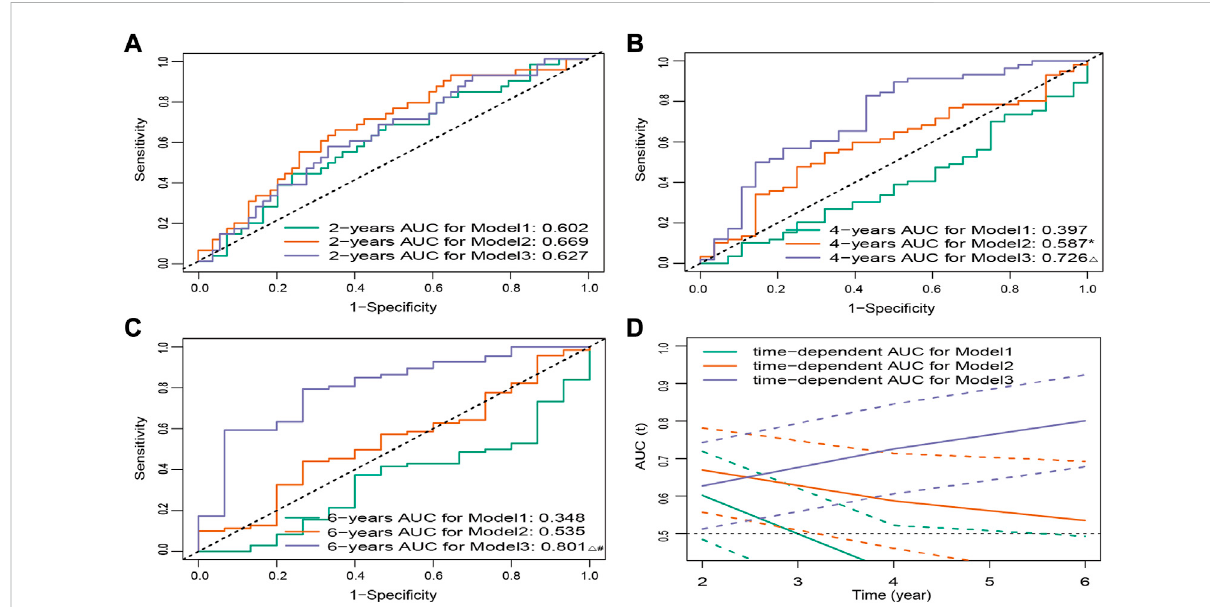
FIGURE 5 ROC curves for three models of predicting 2- (A) , 4- (B) , and 6-year (C) OS. * p < 0.05 versus Model1, △ p < 0.001 versus Model1, # p < 0.05versusModel2. (D) Time-dependentROCcurvesforthreemodelsintheICGCcohort.Dashedlinesrepresent95%CIs.ROC,receiveroperating characteristic; OS, overall survival; ICGC, International Cancer Genome Consortium; CI, con fi dence interval.